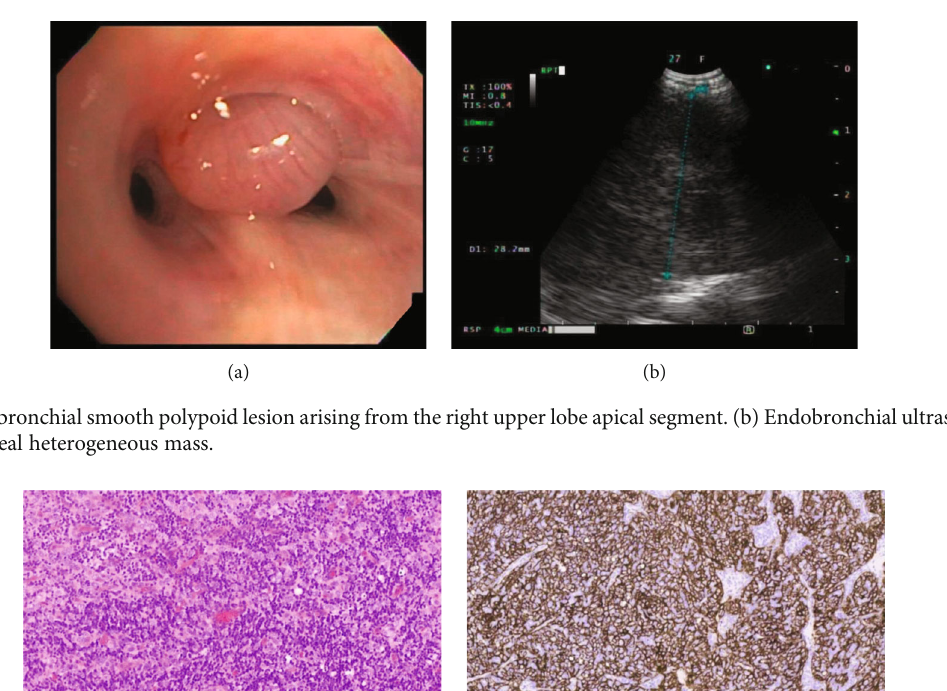
Figure 1: (a) Computed tomography image of the chest depicting a large right upper paratracheal mass. (b) Computed tomography image of the chest depicting pleural and pericardial.